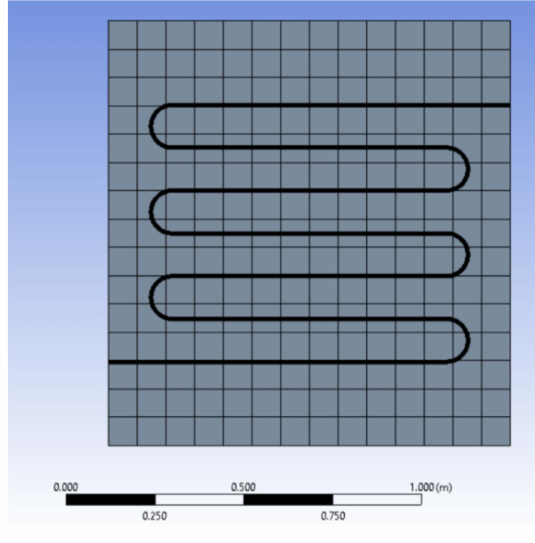
Figure 3. Mesh generation of the